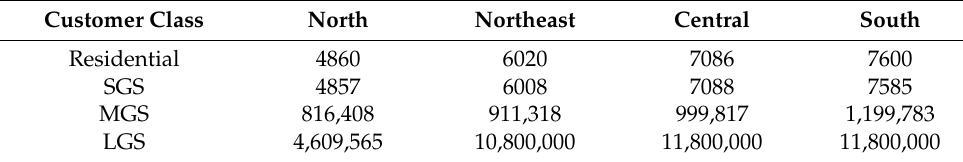
Table A5. Annual load in the first year of each customer type by region